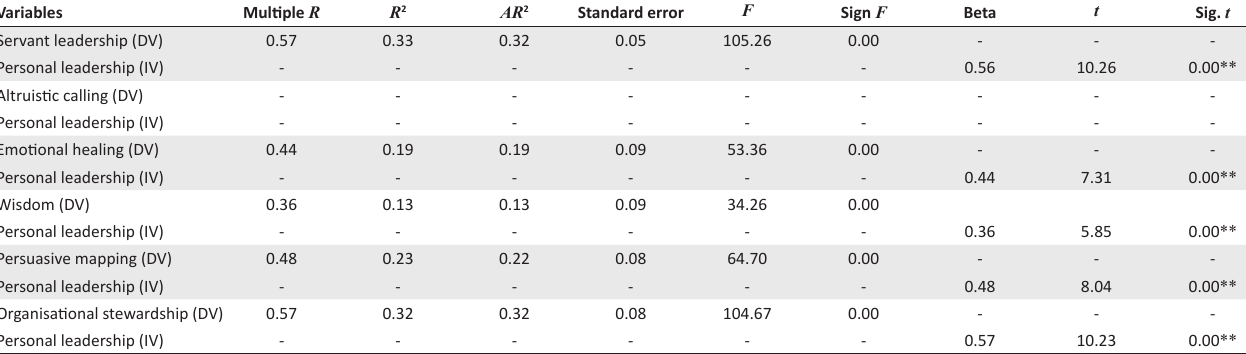
TABLE 4: Results of regression analysis with personal leadership predicting servant leadership. Variables